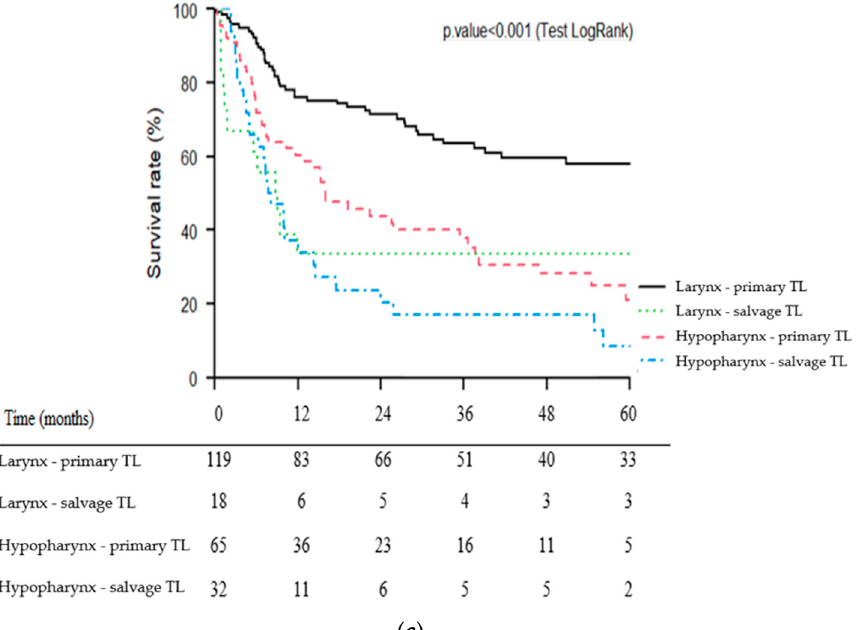
Figure 3. Kaplan–Meier overall ( a ), cause-specific ( b ) and recurrence-free ( c ) survival curves for patients undergoing primary vs. salvage total laryngectomy (TL) according to primary tumor site (larynx vs. hypopharynx).